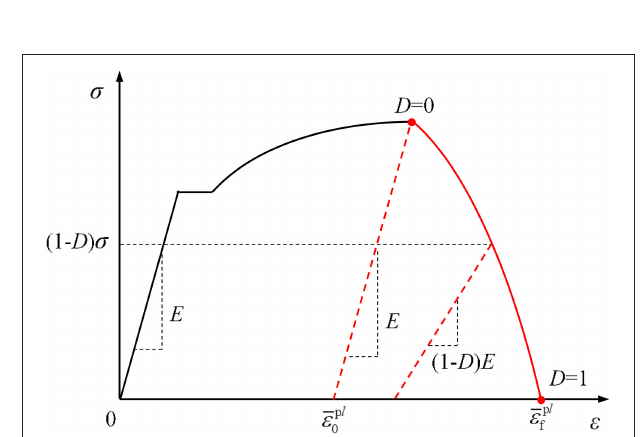
FIGURE 2 | The comprehensive fracture criterion of steel based on stress triaxiality. FIGURE 3 | The damage evolution path of